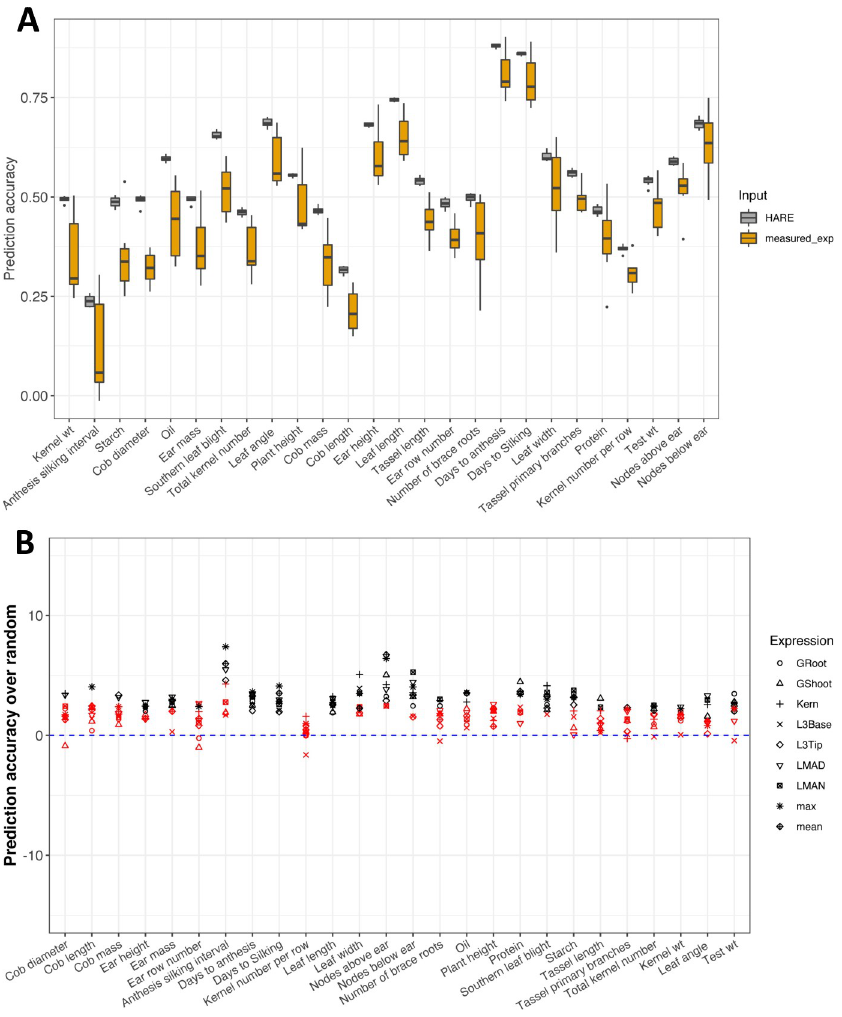
Fig 5. HARE improved within-panel prediction accuracy over measured expression and random HARE for most of the traits. (A) Prediction accuracy within the Goodman Association panel using HARE and measured expression (measured_exp) from all tissues arranged by prediction differential. (B) Change in prediction accuracy using HARE over the mean accuracy from random HARE (blue dashed line). Different symbols represent HARE from different tissues. The black shapes represent statistically significant differences at P-value < 0.05 and red shapes are without significant differences. P-values calculated using Monte Carlo procedure.